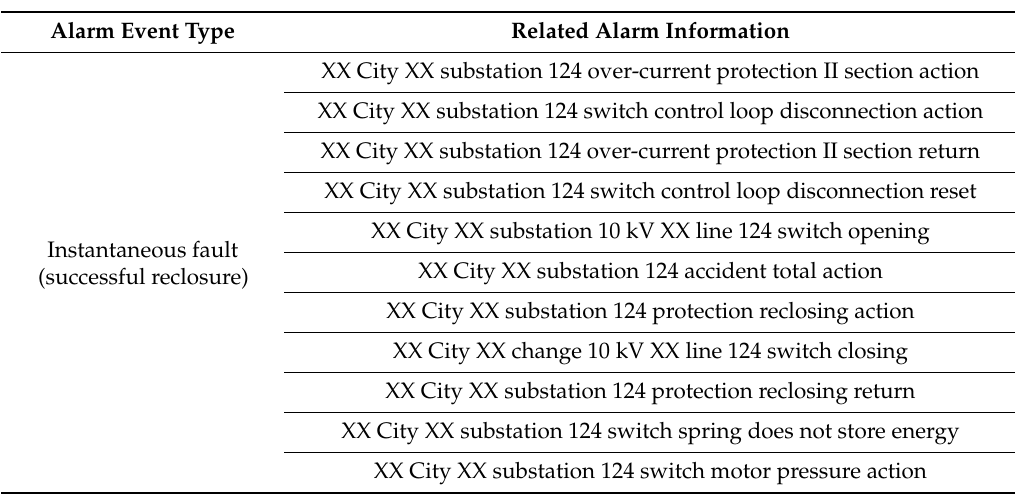
Table 1. Example of an alarm event sample.